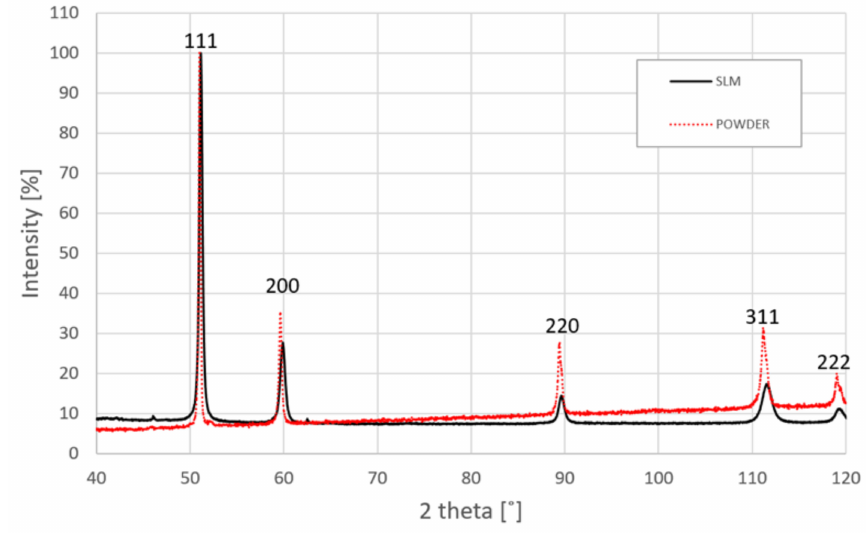
Figure 13. The X-ray di ff raction (XRD) pattern of the SS316L structure produced by